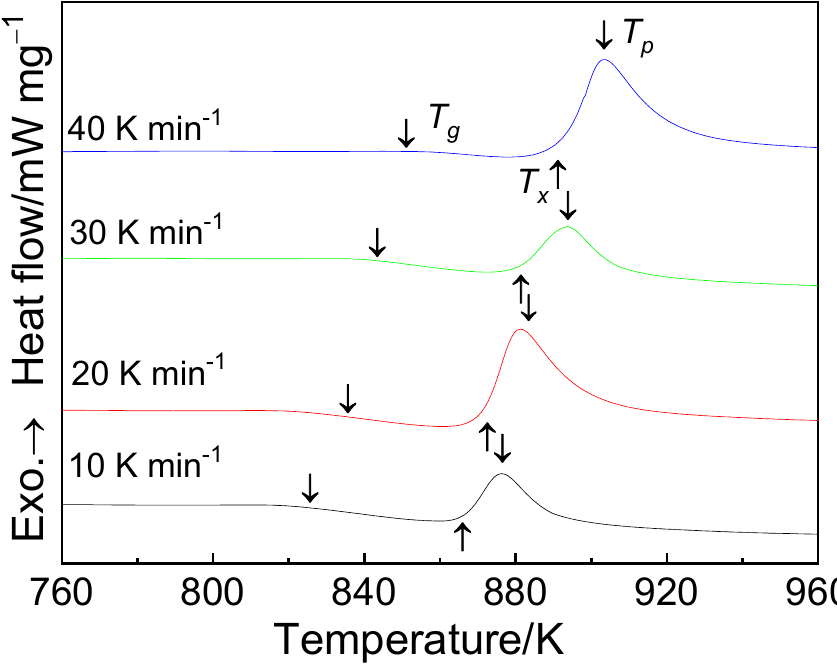
Figure 2. DSC traces for the Fe 68 Nb 6 B 23 Mo 3 glassy alloys under varied heating rates. Table 1. Thermal properties of the Fe 68 Nb 6 B 23 Mo 3 glassy alloys under varied heating rates. Heating Rate (K min − 1